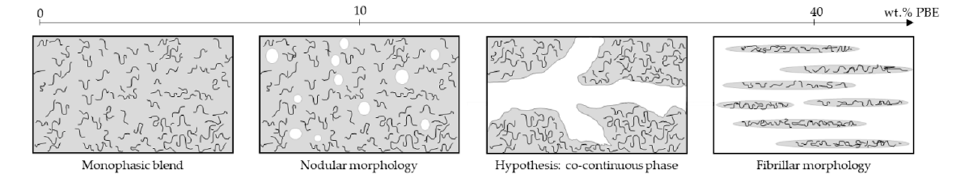
Figure 3. Hypothesis of the evolution of phases with the addition of PBE in the blend.